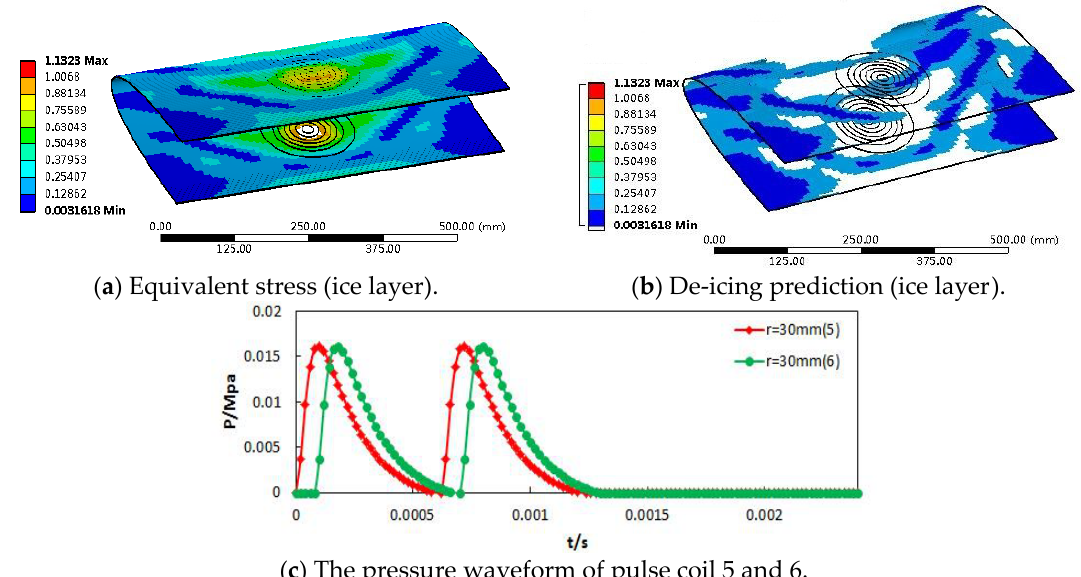
Figure 19. De-icing results of pulse coil 6 starting 100 μs later than coil 5. Aerospace 2019 , 6 , x FOR PEER REVIEW 13 of 15